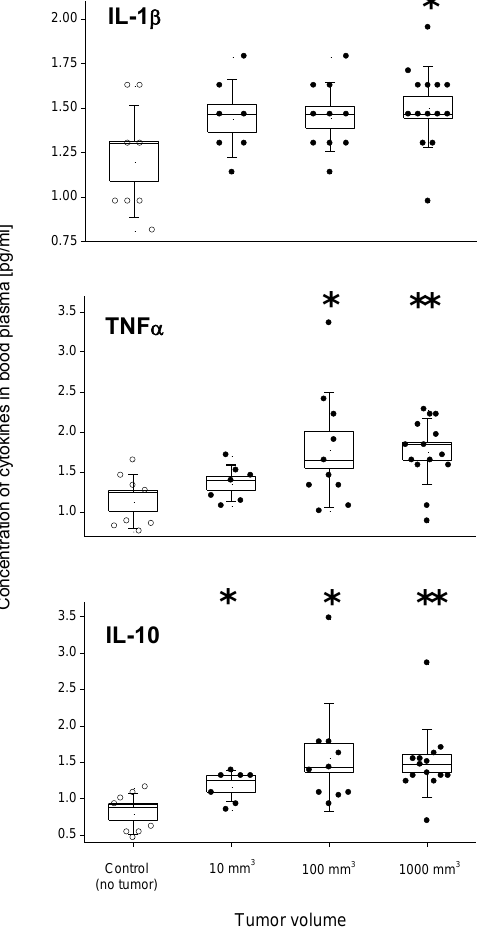
Figure 3. The concentrations of inflammatory cytokines, IL-1 β , TNF α , and IL-10 in serum of DBA/2 mice: Analysis was carried out in control animals (no tumor) and in the mice with subcutaneous S91 tumor at the early (size above 10 mm 3 ), moderately advanced (size above 100 mm 3 ), and advanced stage of growth (size above 1000 mm 3 ). Cytokine concentrations were determined in blood plasma collected from the hearts of animals using a Luminex ® analyzer (see the text for details). The range indicated by the box defines the mean ± standard error (SE), and that indicated by the error bars the mean ± standard deviation (SD). The horizontal line defines the median and the points indicate the values of the individual measurements. The statistical significance of the differences between the meanings, compared to the controls, was determined using the t test. * p < 0.05, ** p < 0.01. Compared to the healthy animals, the highest changes in the IL-1 β and TNF α concentrations in the peripheral blood of tumor-bearing mice are statistically significant ( p < 0.02 and 0.002,